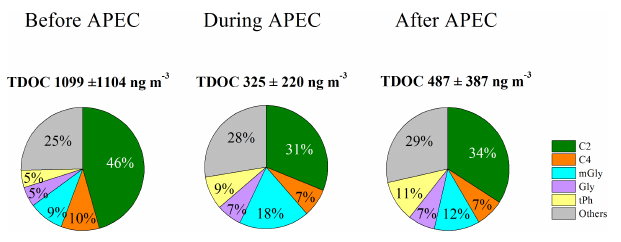
Figure 4. Compositions of total detected organic compounds (TDOC) in PM 2 . 5 during the 2014 APEC